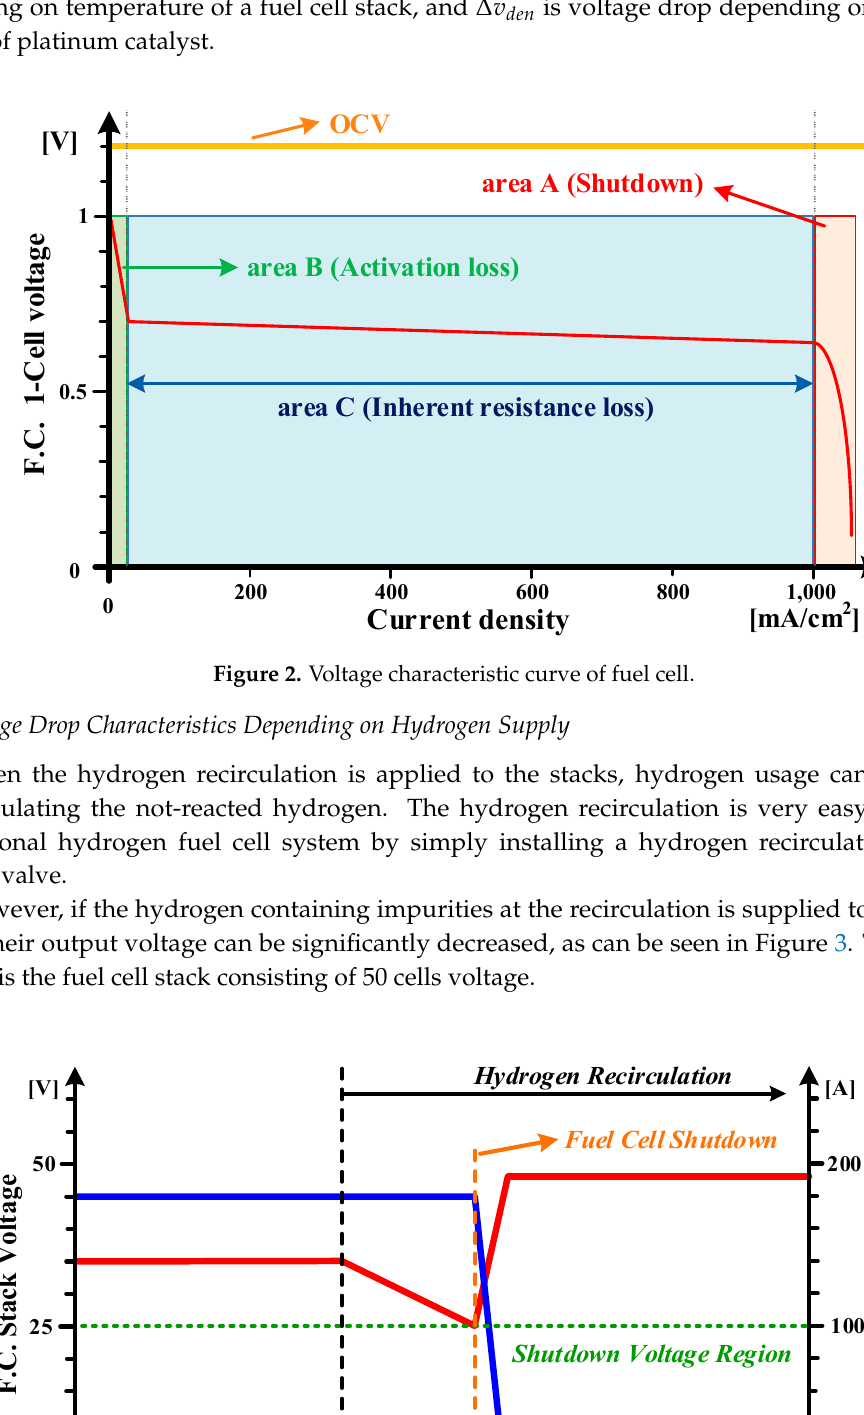
[A] Figure 4. Voltage characteristic curve depending on the amount of hydrogen supply.